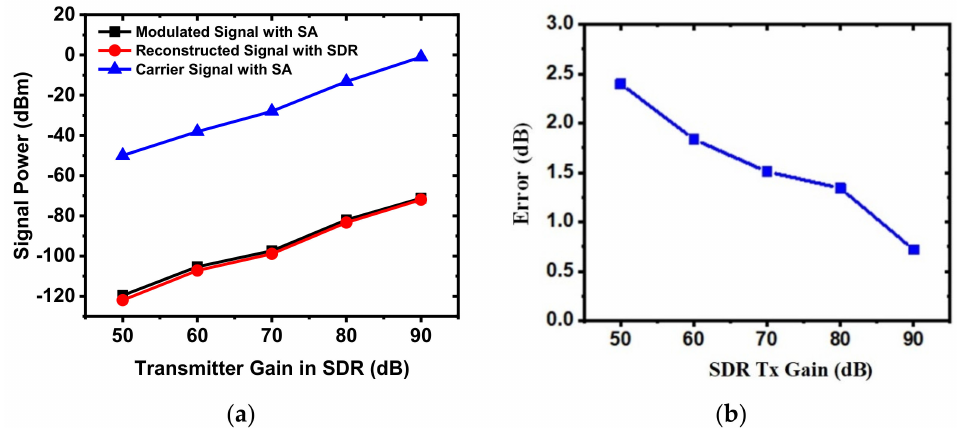
Figure 6. ( a ) Results from power measurements with a spectrum analyzer (SA) and the SDR (set to 61 dB receiver gain); ( b ) measured error vs. SDR Tx gain.